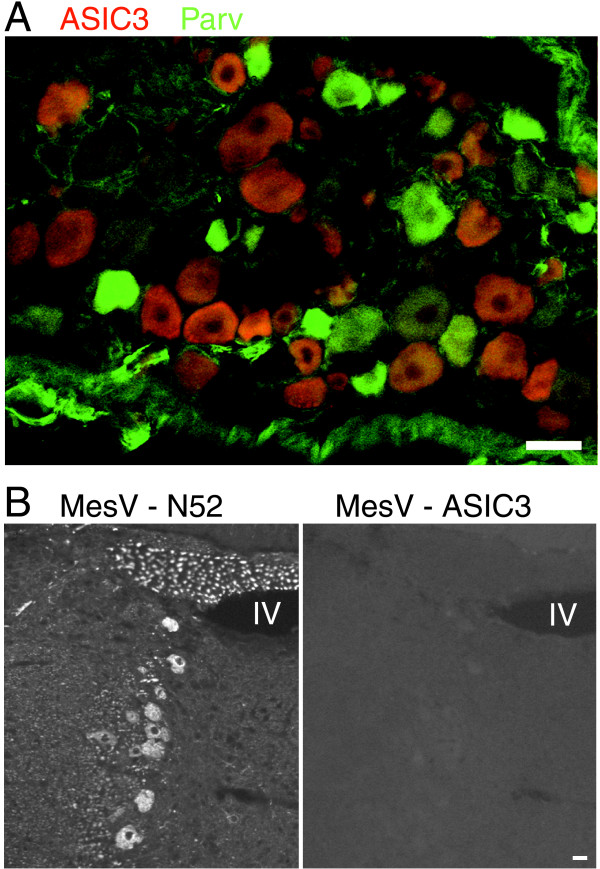
ASIC3 is not expressed by muscle spindle afferents. A, Section of DRG labeled for ASIC3 (red) and for the calcium-binding protein parvalbumin (green), which labels muscle spindle afferents. Only 2 of 1400 parvalbumin-positive cells had detectable ASIC3 staining. B, Section of brainstem containing a string of sensory neurons in the mesencephalic nucleus of the 5th nerve (MesV) stained with either an antibody to a neurofilament protein (N52) to reveal all the sensory neurons (left, string of large cells arranged vertically; top punctuate labeling are MesV axons in cross section) or with the ASIC3 antibody (right). No MesV cells expressed ASIC3 (n = 3 rats). "IV" marks the fourth ventricle. Scale bars, 40 μm.